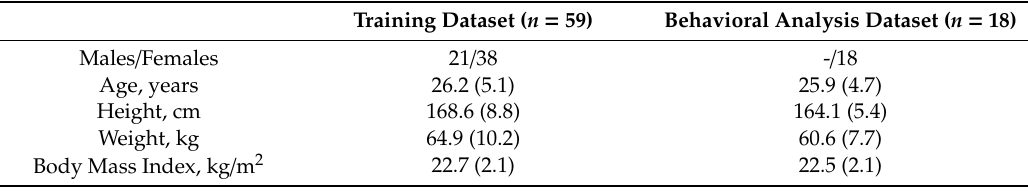
Table 2. Group characteristics for the two assembled